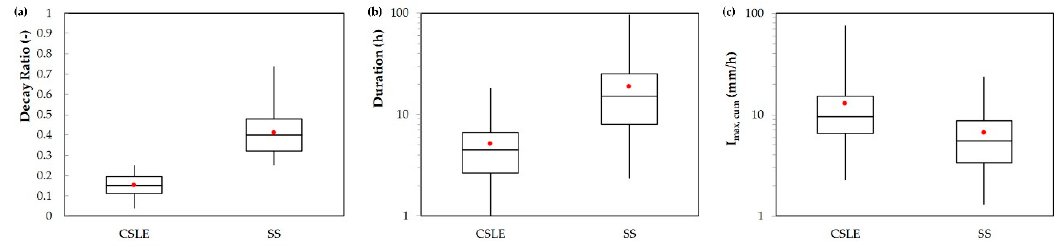
Figure 3. Comparison of box-plots for Decay Ratio (DR) ( a ), event duration ( b ) and I max, cum ( c ). On the contrary, significant intersects can be highlighted by analyzing the box-plots for d and